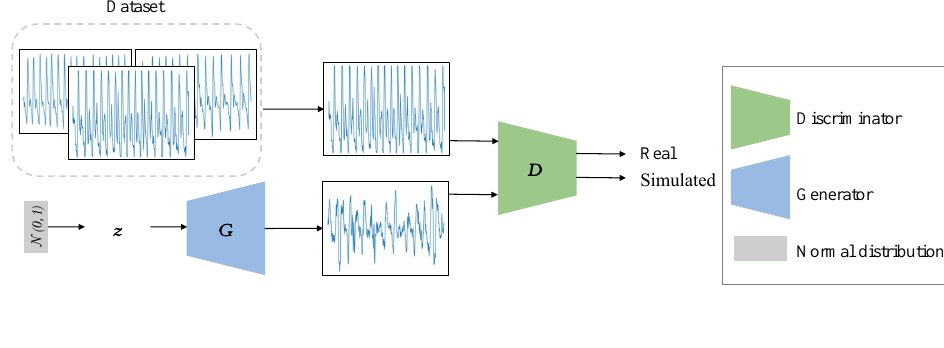
Figure 1. Architecture of the Vanilla